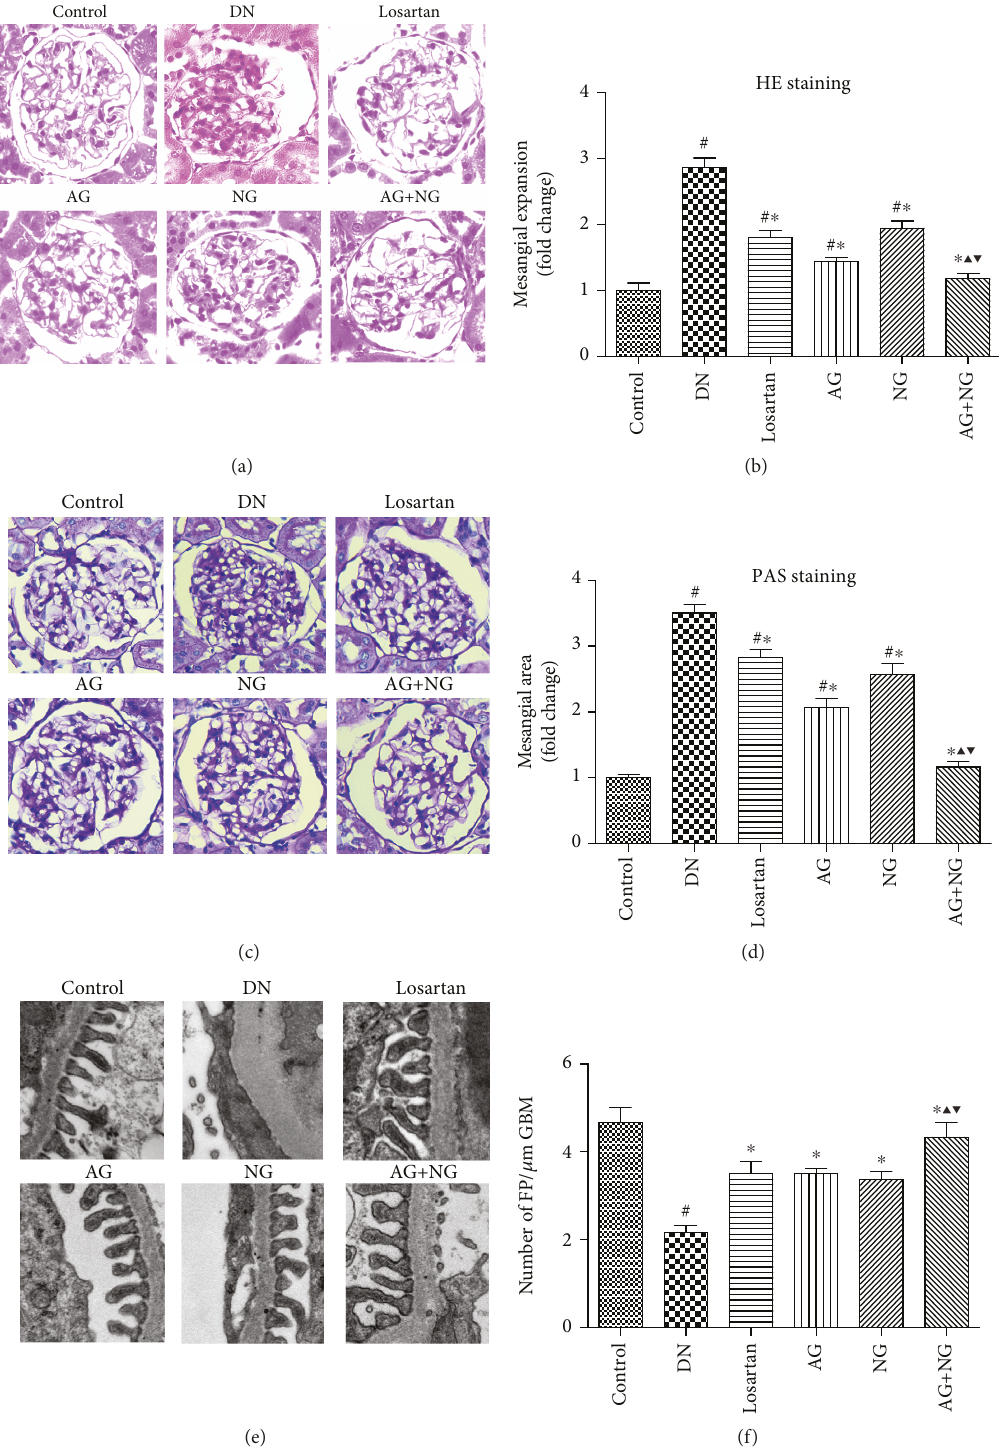
Figure 2: E ff ects of AG and NG on renal histopathology and podocyte foot process e ff acement in diabetic rats. Representative hematoxylin and eosin (H&E, kidney histology ( × 400)) staining (a) and periodic acid-Schi ff (PAS, kidney histology ( × 400)) staining (c) of kidney sections. Representative ultrastructure photos of glomerular podocytes taken by transmission electron microscopy (TEM) ( × 13500) (e). Semiquantitative analysis of mesangial expansion (b), mesangial area (d), and podocyte foot process density (f). FP: foot process; GBM: glomerular basement membrane; control: normal control rats; DN: STZ-induced diabetic rats; losartan: DN rats treated with losartan; AG: DN rats treated with Astragalus membranaceus; NG: DN rats treated with Panax notoginseng; AG+NG: DN rats treated with Astragalus membranaceus plus Panax notoginseng. Results were expressed as the mean ± SD . # P < 0 05 vs. control group, ∗ P < 0 05 vs. DN group, ▲ P < 0 05 vs. AG group, ▼ P < 0 05 vs. NG